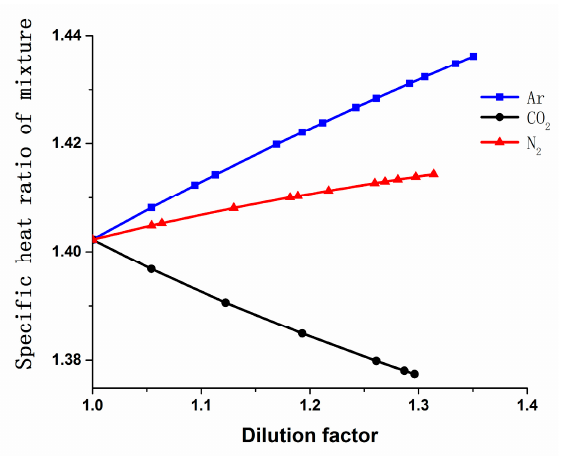
Figure 3. Variation in the mixture specific heat ratio vs. the DF of CO 2 , N 2 , and Ar.